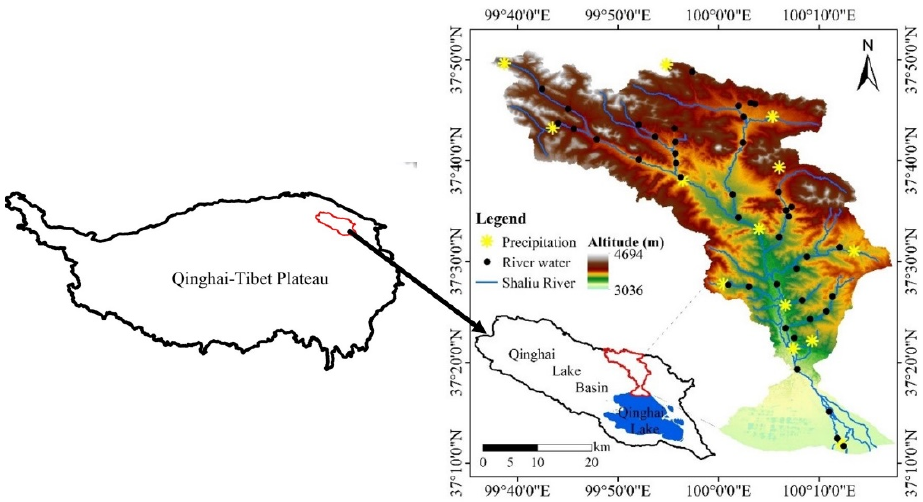
Figure 1. Location of the study area and water sampling